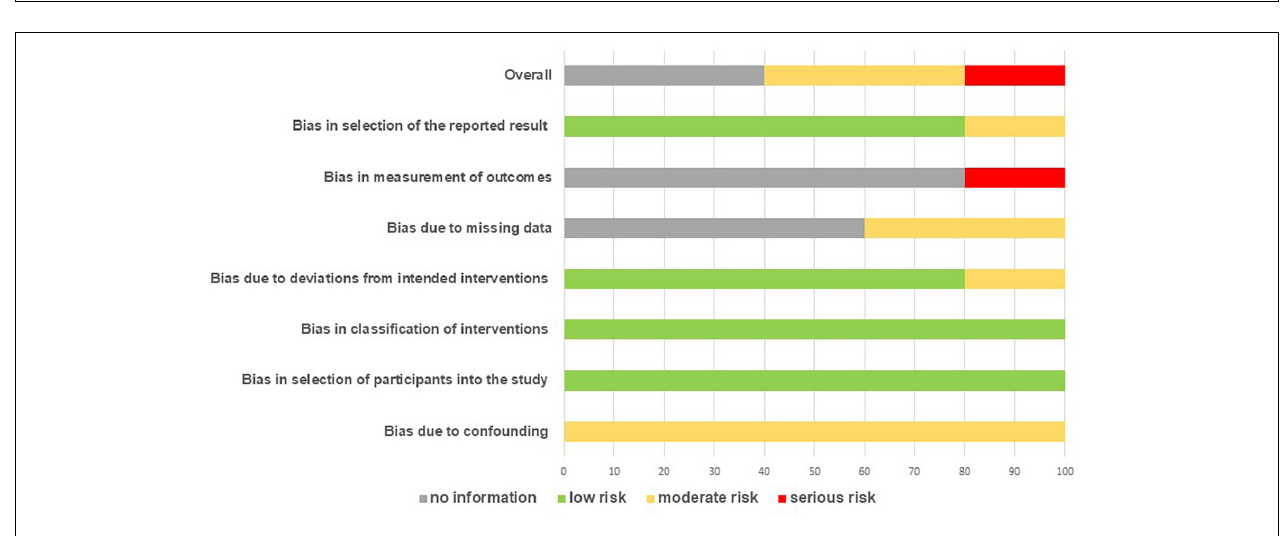
FIGURE 3 | Percentages summary of risk-of-bias assessment using the ROBIN-I